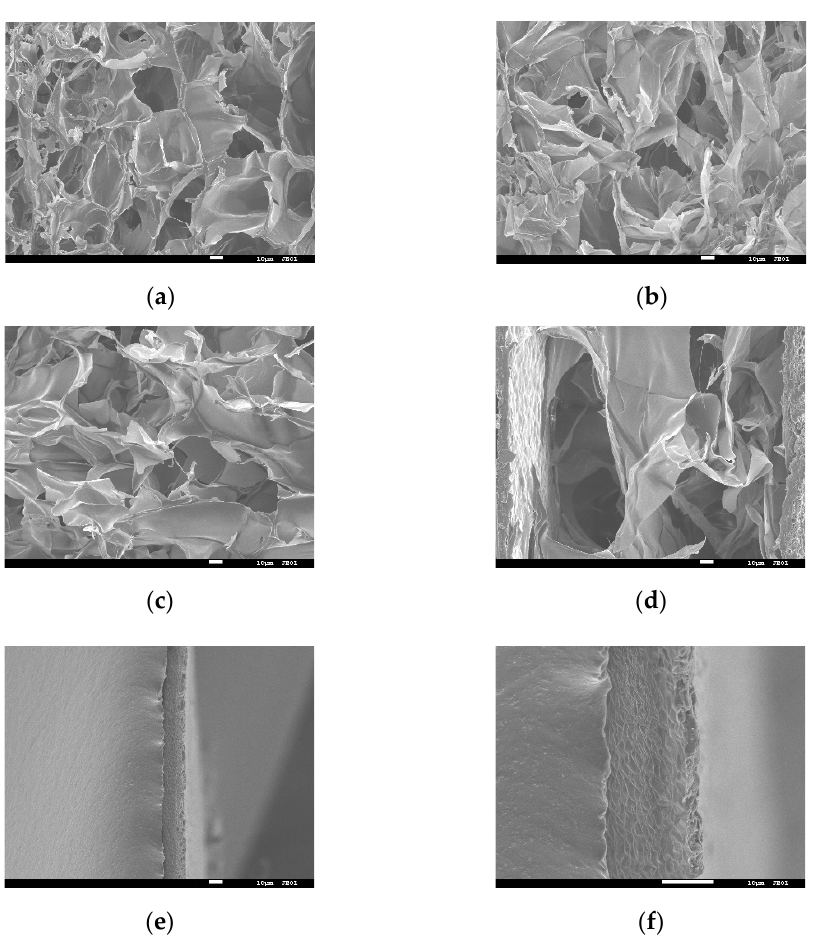
Figure 1. The transverse relaxation time (T 2 ) curves of the raw and cooked U. pinnatifida under dif- ferent cooking methods.